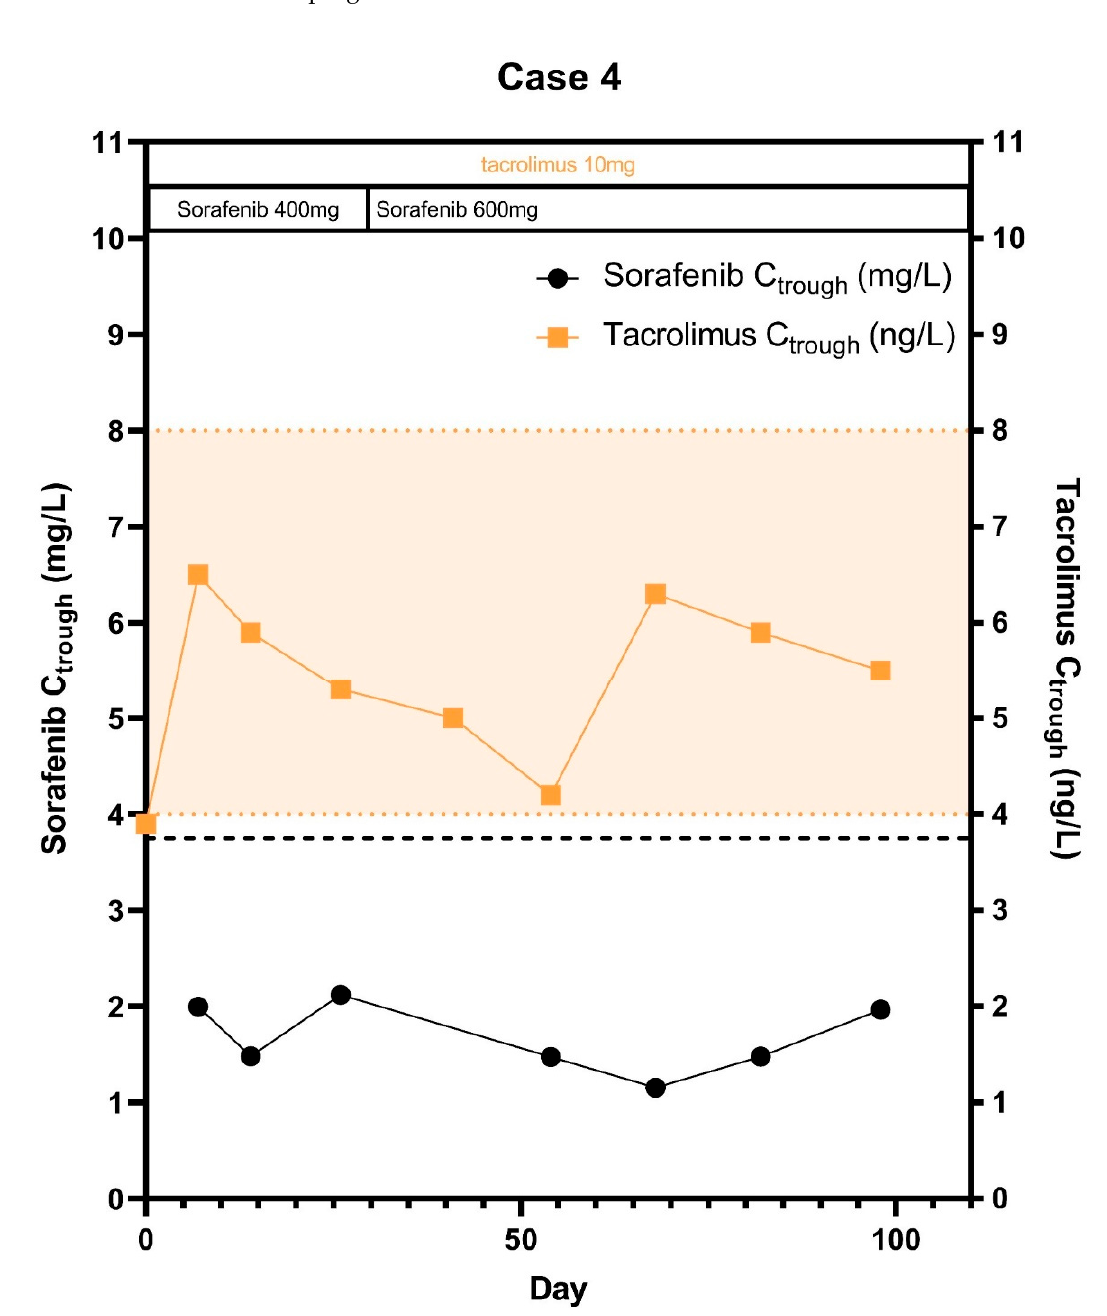
Figure 4. Sorafenib and tacrolimus C trough concentrations over time for Subject 4: The C trough levels are displayed over time after the start of sorafenib treatment. Furthermore the optimal C trough levels of both sorafenib and tacrolimus are provided.